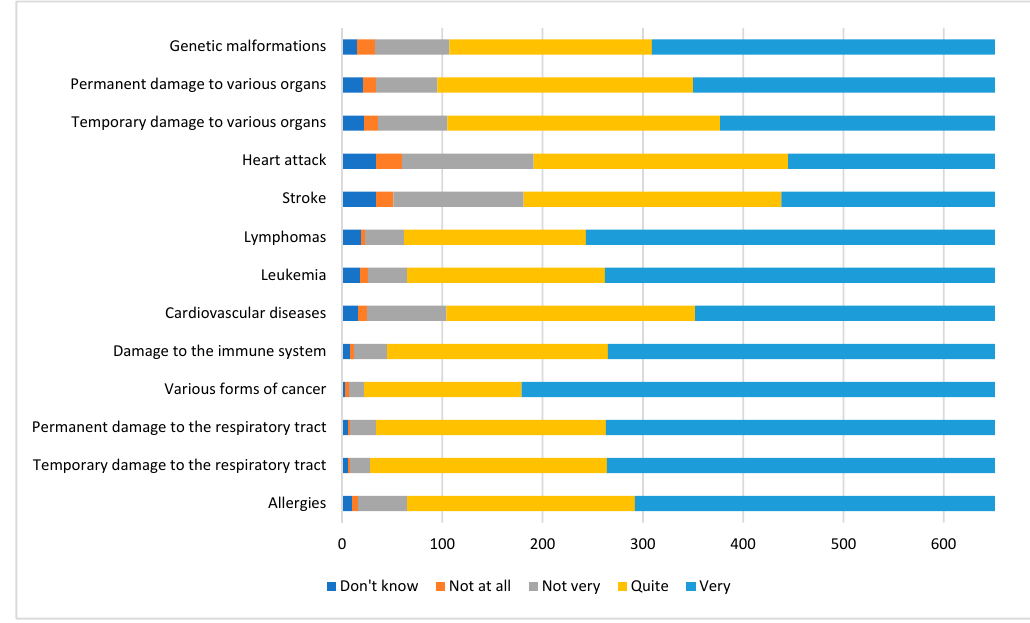
Figure 5. Health concerns declared by respondents. Int. J. Environ. Res. Public Health 2020 , 17 , x